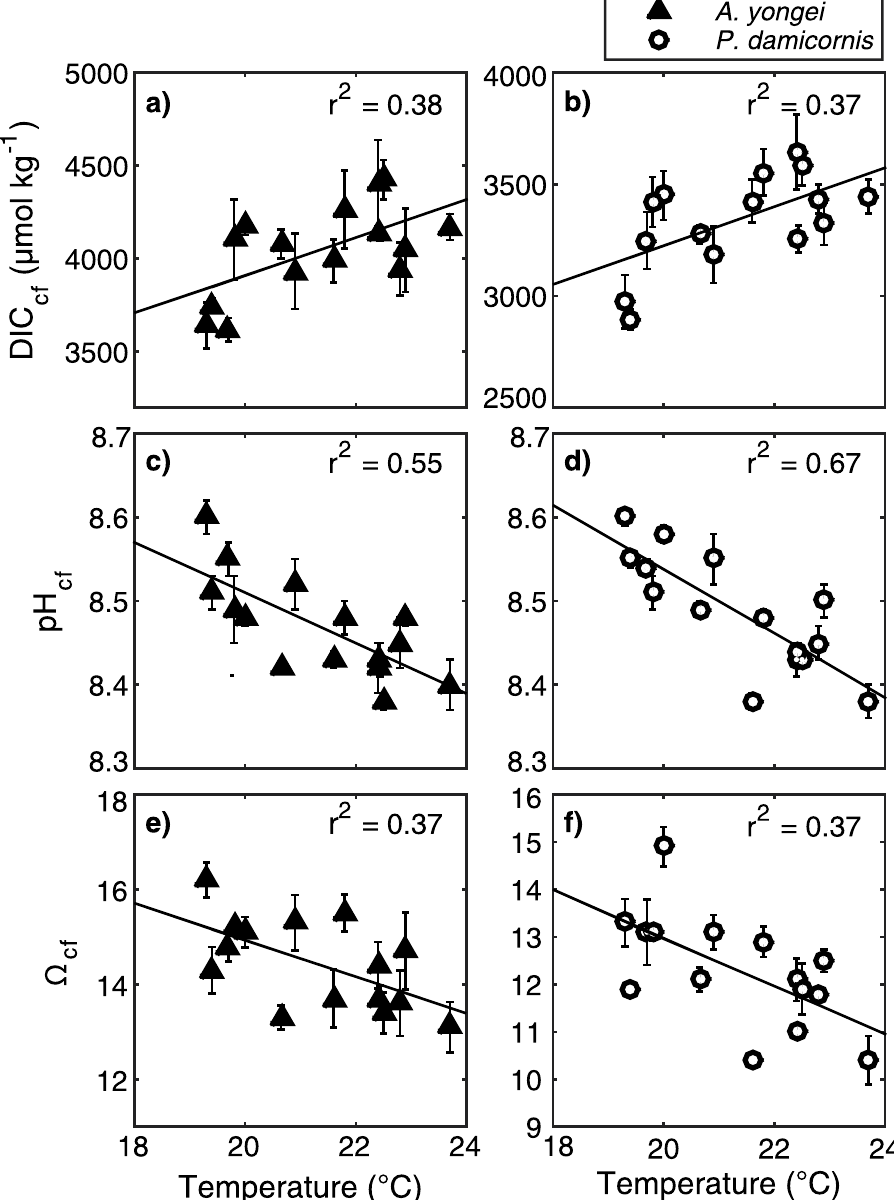
Figure 4. Relationships between calcifying fluid parameters versus seawater temperature. ( a,b ) Seasonal changes in DIC cf , ( c,d ) pH cf , and ( e,f ) Ω cf with seawater temperatures for Acropora yongei and Pocillopora damicornis averaged ( ± 1 SE) over each growth